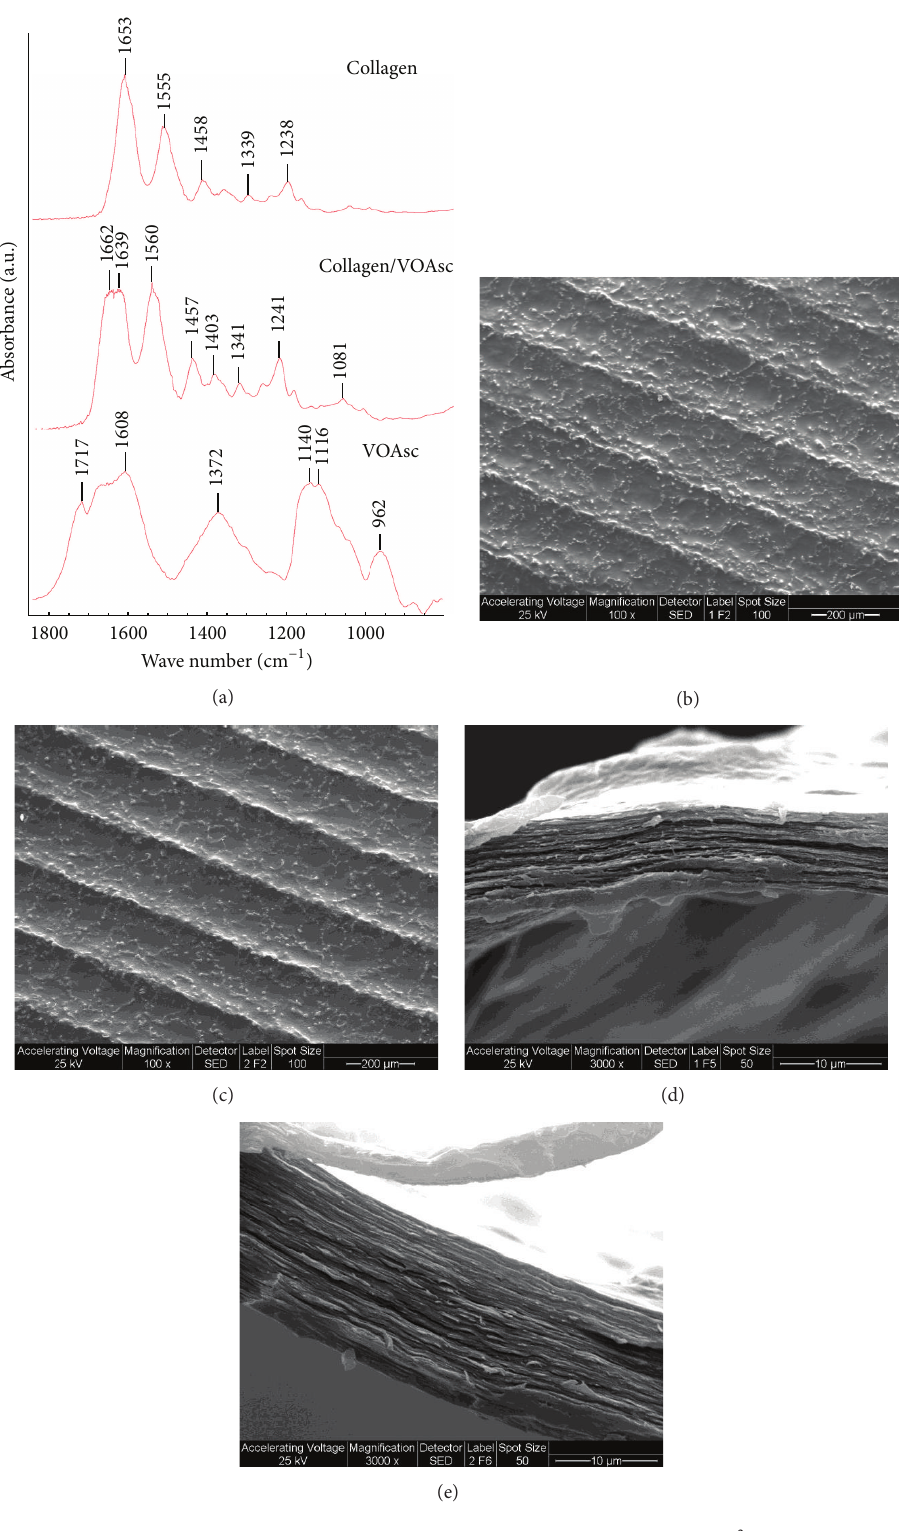
Figure 1: Characterization of Col and Col-V scaffolds. FTIR spectra of Col, Col-V (20 𝜇 g/mL per cm 2 VOAsc) membrane, and the VOAsc complex (a). SEM images of Col and Col-V surfaces ((b) and (c), resp.) showed an ordered matrix with a grooved structure. Transversal section of Col and Col-V films ((d) and (e),